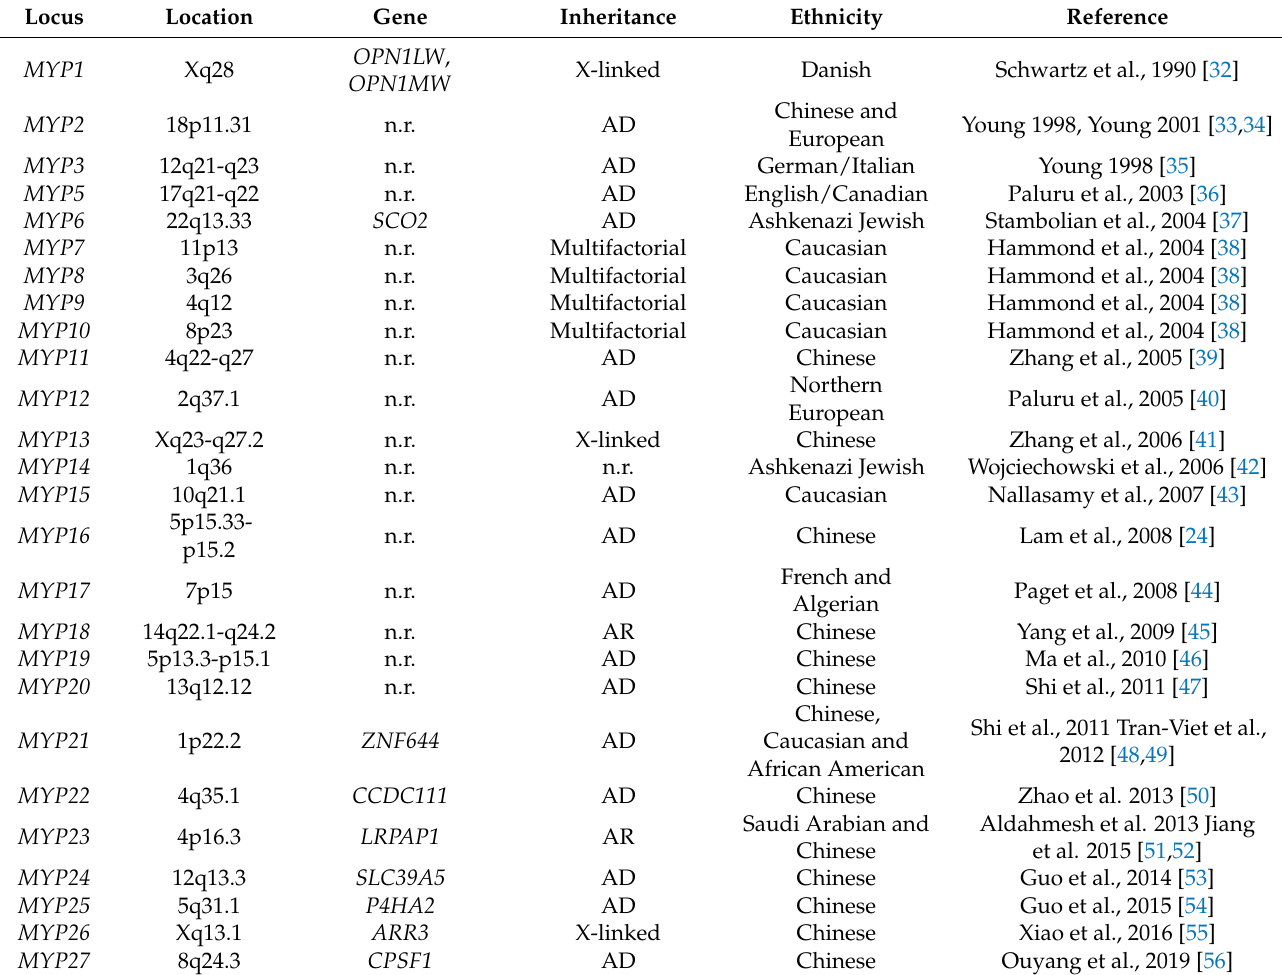
Table 1. Gene loci identified for myopia from linkage analysis and sequencing